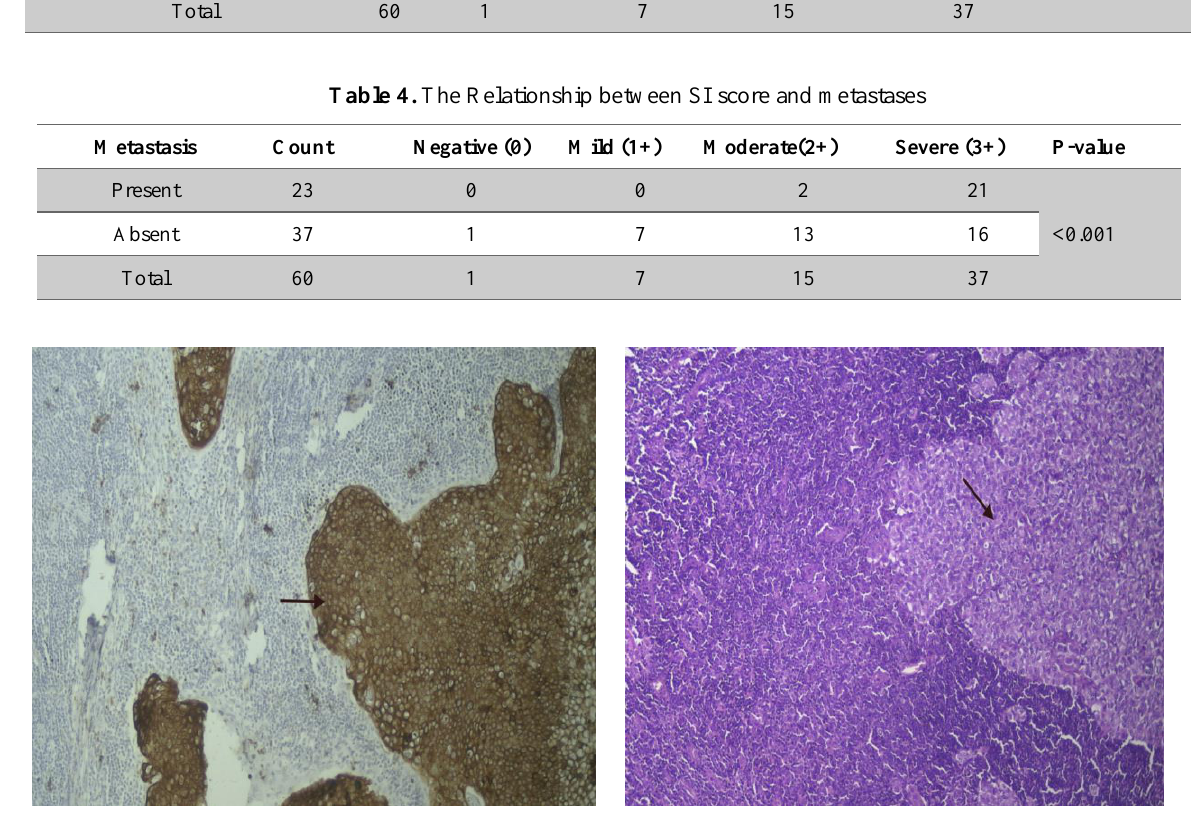
Figure 5. Severe staining for COX-2 in a metastatic lymph node at X100 magnification.